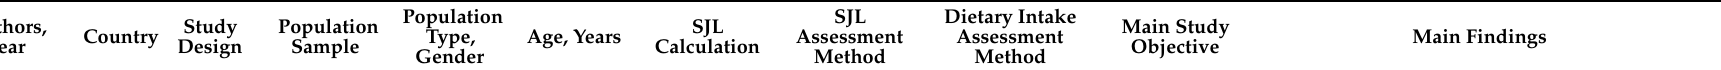
Table 1. Studies reporting the association of social jetlag with dietary